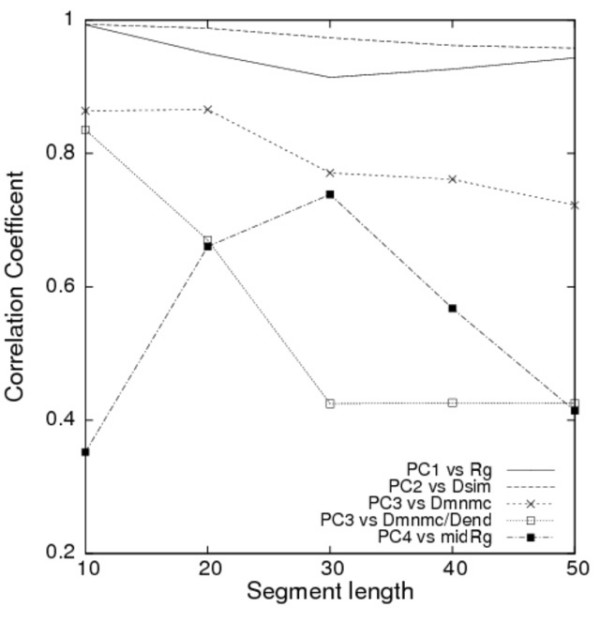
Correlation coefficients between conformational deviation along each PC axis and physical indicator. The radius of gyration (Rg) for PCall1, structural symmetry related to the N-terminal and C-terminal halves (Dsim) for PCall2, a simple indicator of β-hairpin (Dmn+mc) and Dmn+mc/end-to-end distance (Dend) for PCall3, and the radius of gyration (midRg) around the midpoint of the segment for PCall4 were used in these analyses. Correlation coefficients were calculated at every 10 residues of 10–50 residues.